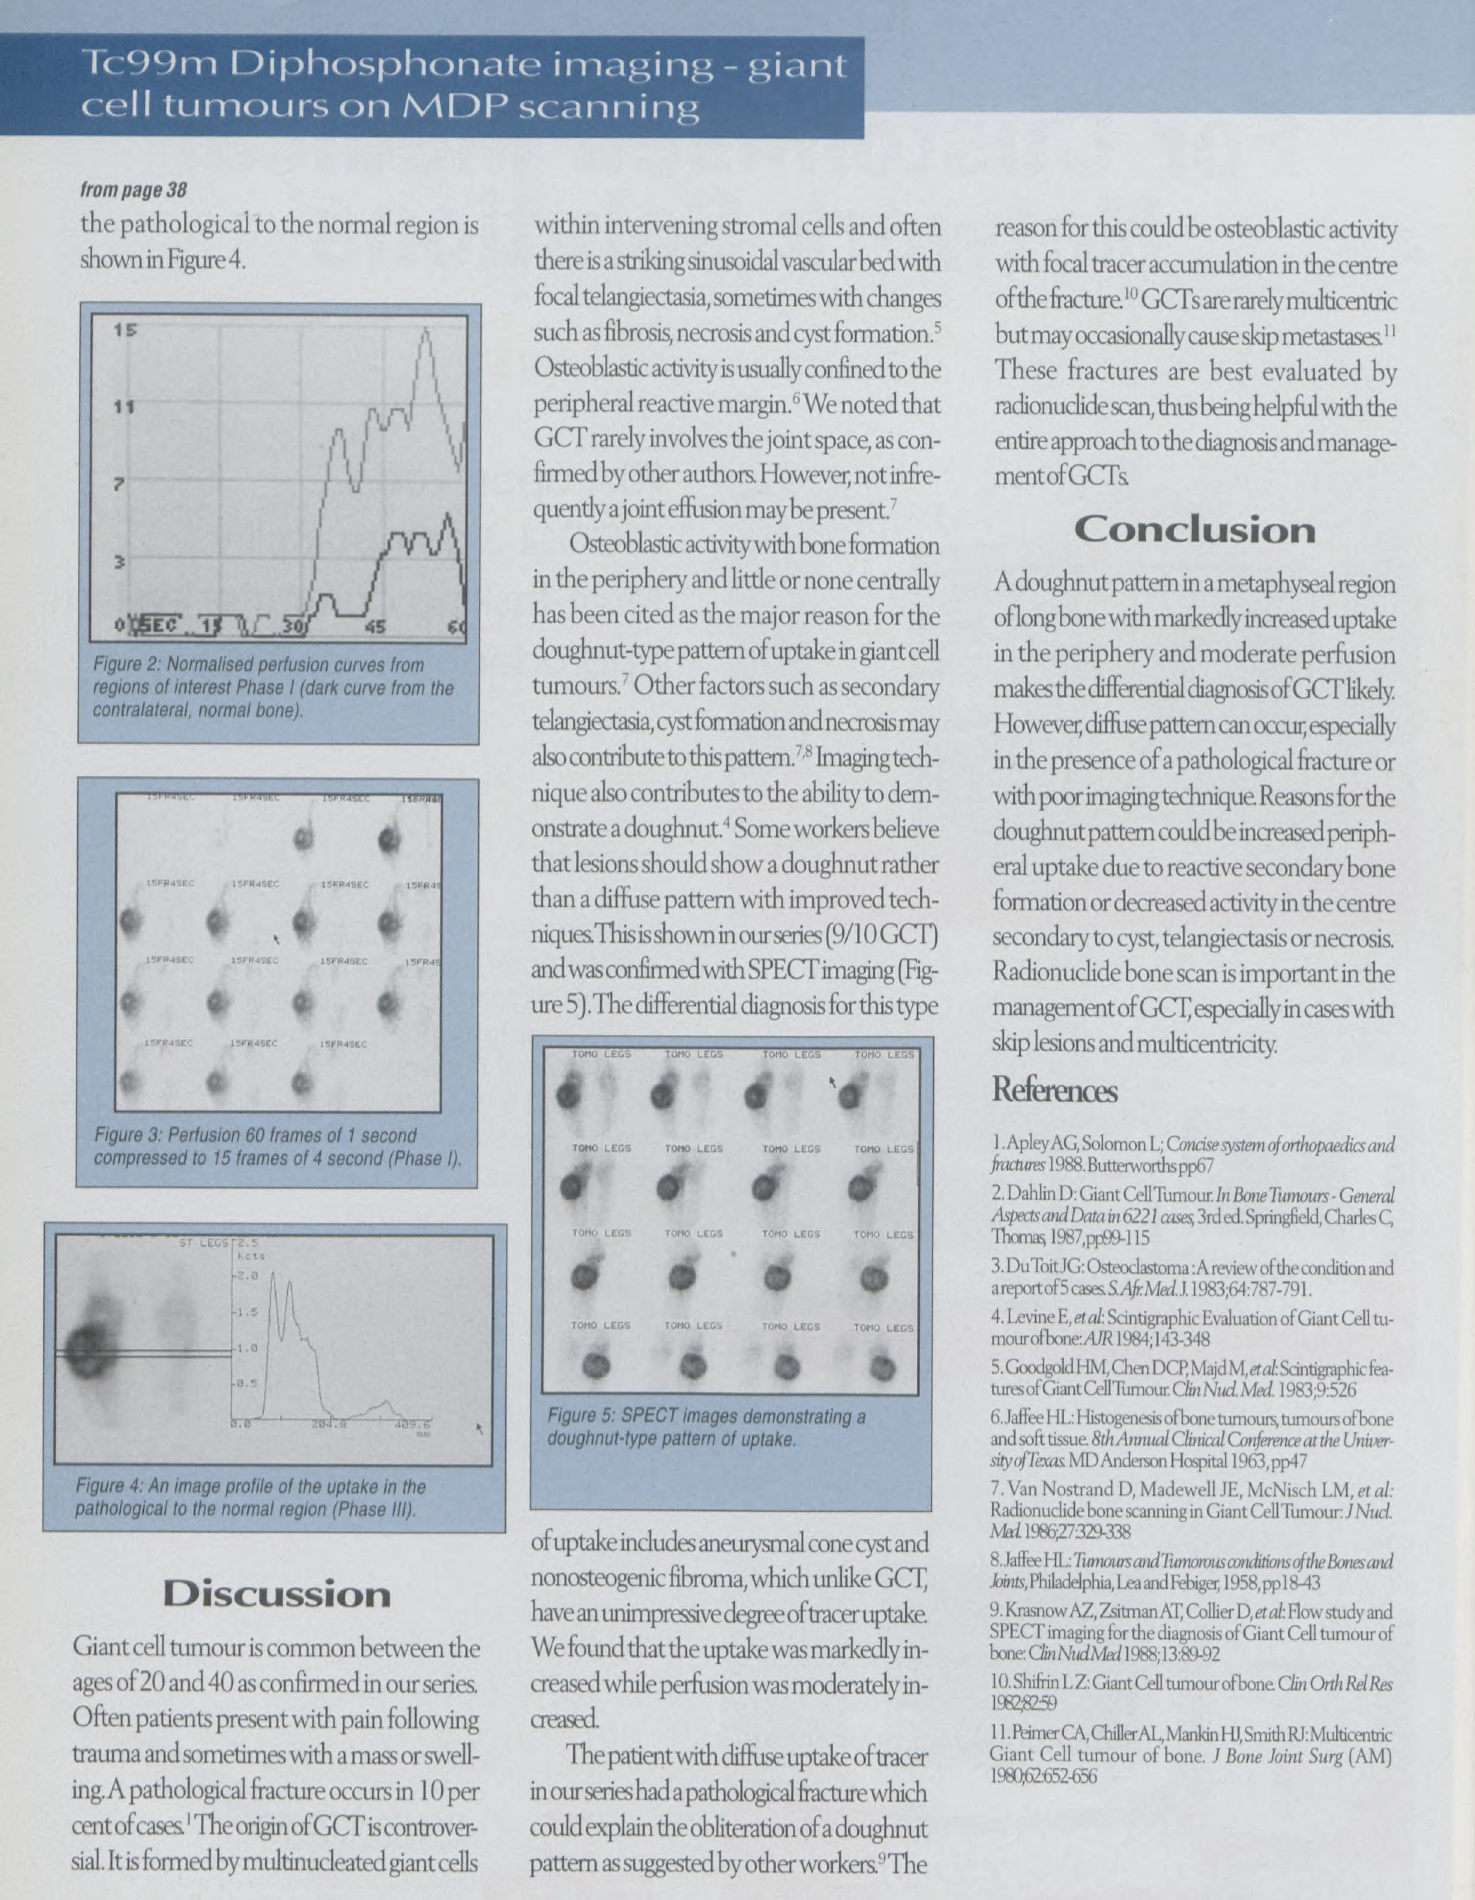
Figure 4: An image profile of the uptake in the pathological to the normal region (Phase 1//).